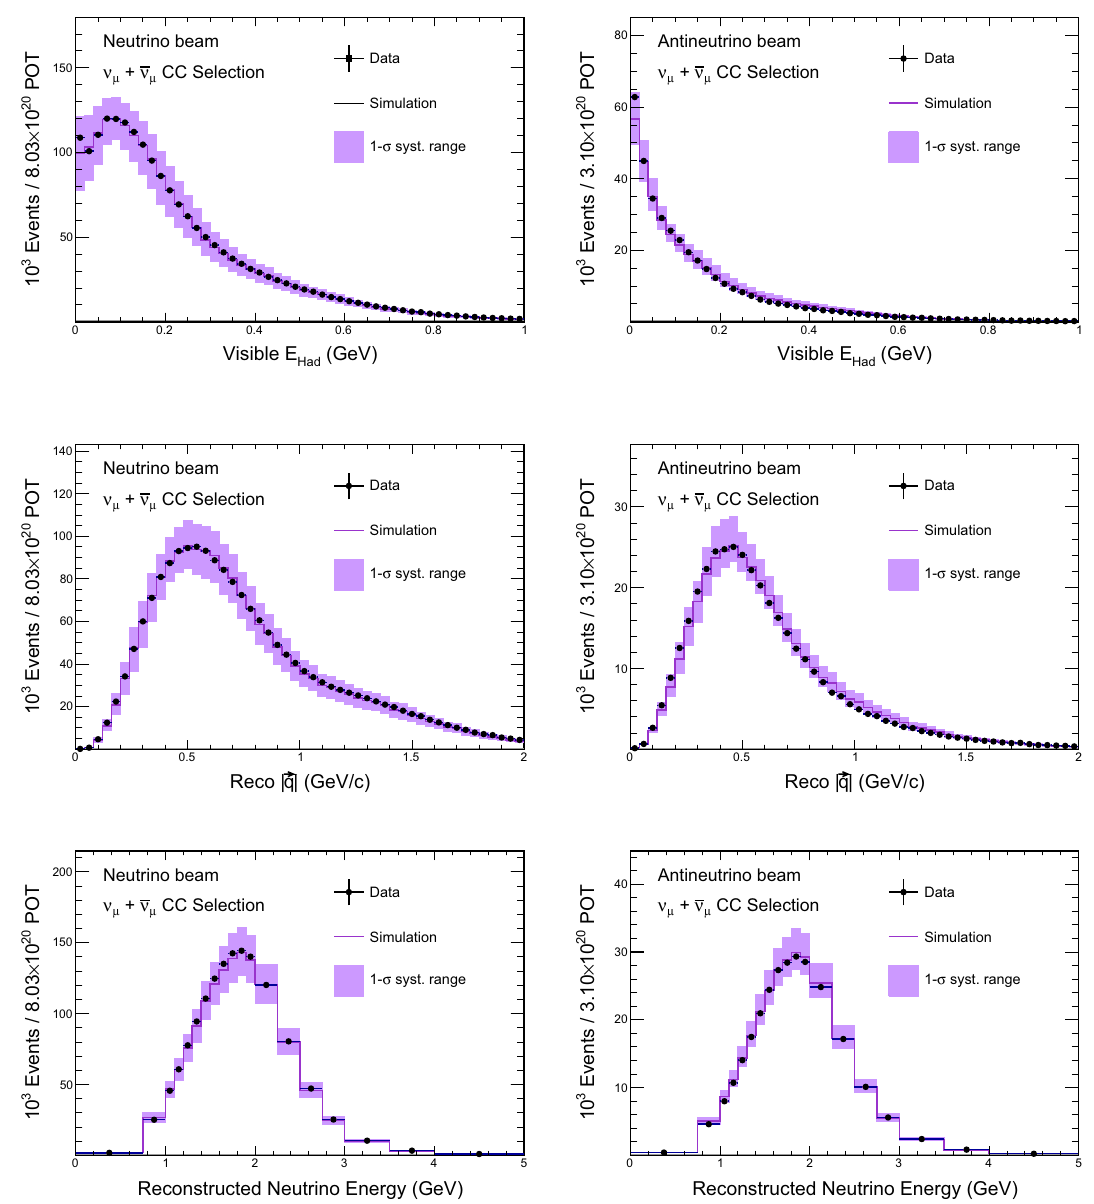
Fig. 12 ND data compared to adjusted simulation with cross-section uncertainties represented by the shaded band. In each bin, the 1 σ deviations from nominal for each cross-section uncertainty are added in quadrature to obtain the band, which has significant bin-to-bin correlations